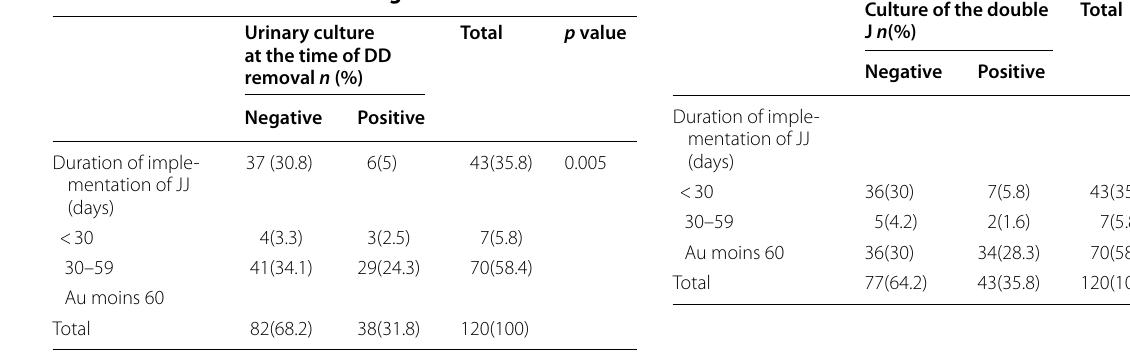
Table 2 Relation between urinary culture at the time of JJ removal and the time of indwelling